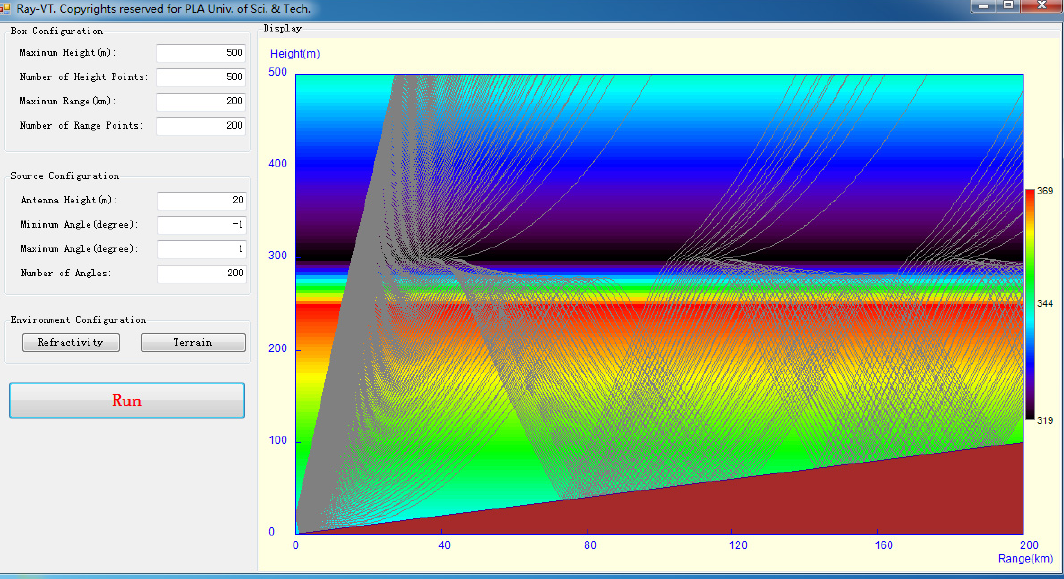
Figure 6. GUI of the Ray-VT for rays propagating through the refractivity fields measured between a Pt. Loma and Guadalupe Island of 12 March 1948. 4. Accuracy Validation The Ray-VT tool is just designed to draw ray paths through a complex environment, and the EM field contributions of rays are not considered. How to use the ray-tracing method to calculate the EM field values is explained in [24], but this method usually fails at focal points and caustics. For EM field calculations, the full-wave methods, for example the PE method, will provide more accurate results. Owing to the field strength having a strong correlation with the ray density [25], the PE method can be used to validate the accuracy of Ray-VT indirectly. In this paper, the TPEM propagation model [10] is used. Figure 7 gives the coverage diagrams of the field strength computed by TPEM, where the antenna source is assumed to be omnidirectional and horizontally polarized with a frequency of 5 GHz. The environmental information in Figure 7a,b corresponds to that in Figures 5 and 6, respectively.